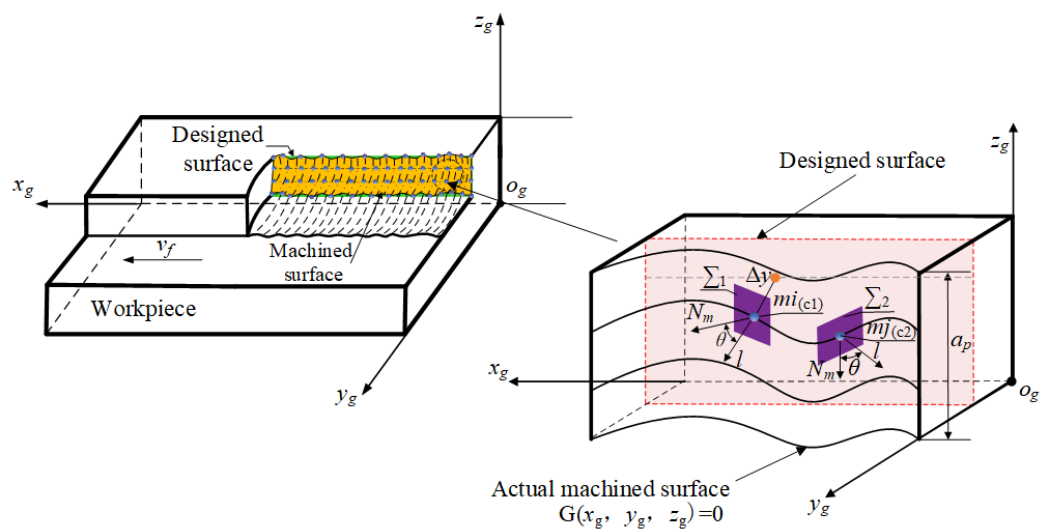
Figure 4. Solution model of positional and angular errors of the machined surface.